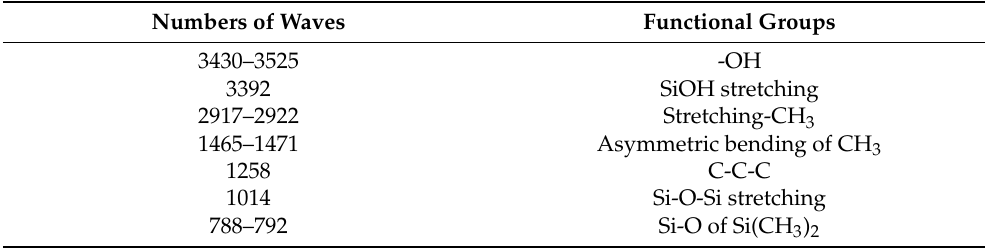
Figure 8. Variation of absorption values at different wavenumbers. ( a ) Absorption values variation at wave number 1014. ( b ) Absorption values variation at wave number 1258. ( c ) Absorption values variation at wave number 2917. ( d ) Variation of absorption values at wave number 3525. Table 2. WAVE NUMBERS IN FUNCTIONAL GROUPS.